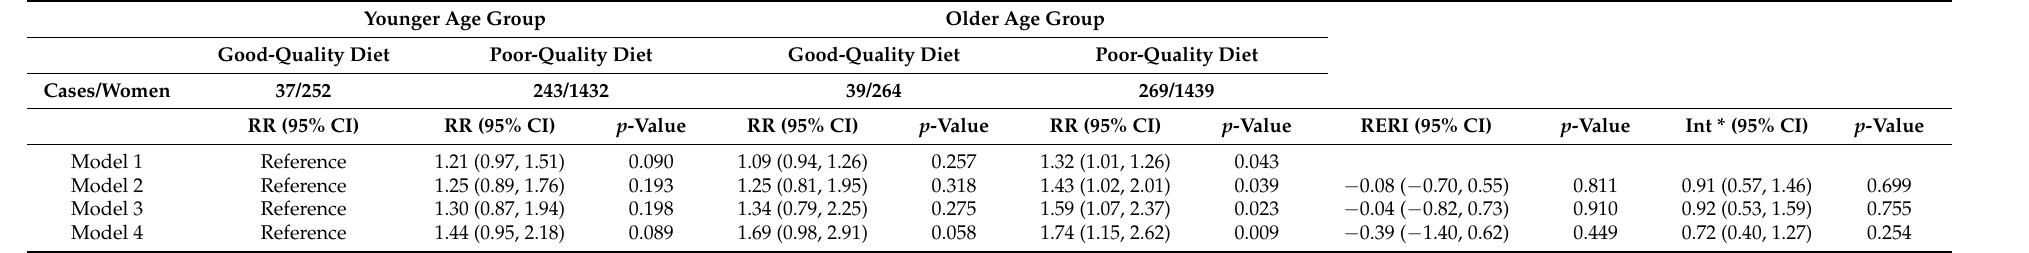
Table 2. Logistic regression models measuring effect modification of age on fertility by diet quality score [Survey 3].